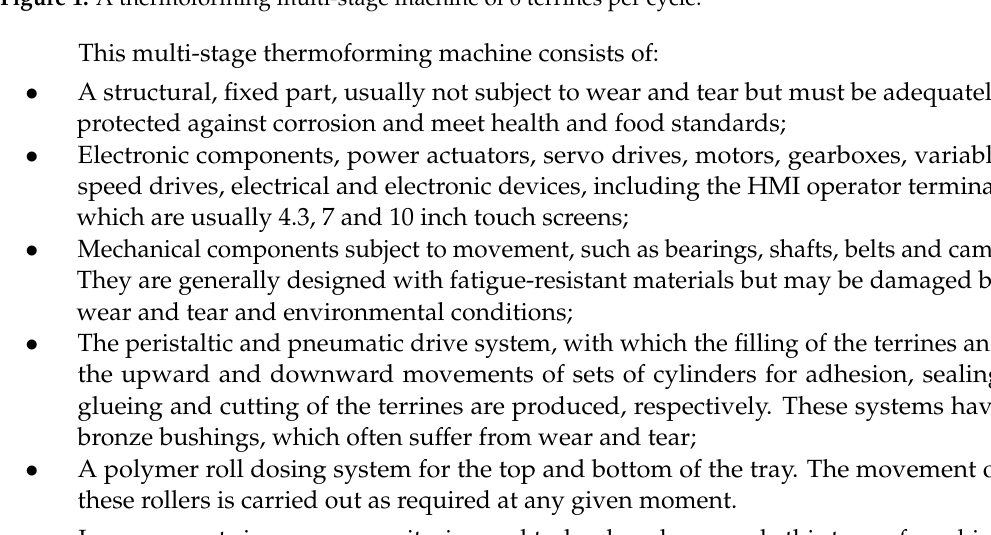
Figure 1. A thermoforming multi-stage machine of 6 terrines per